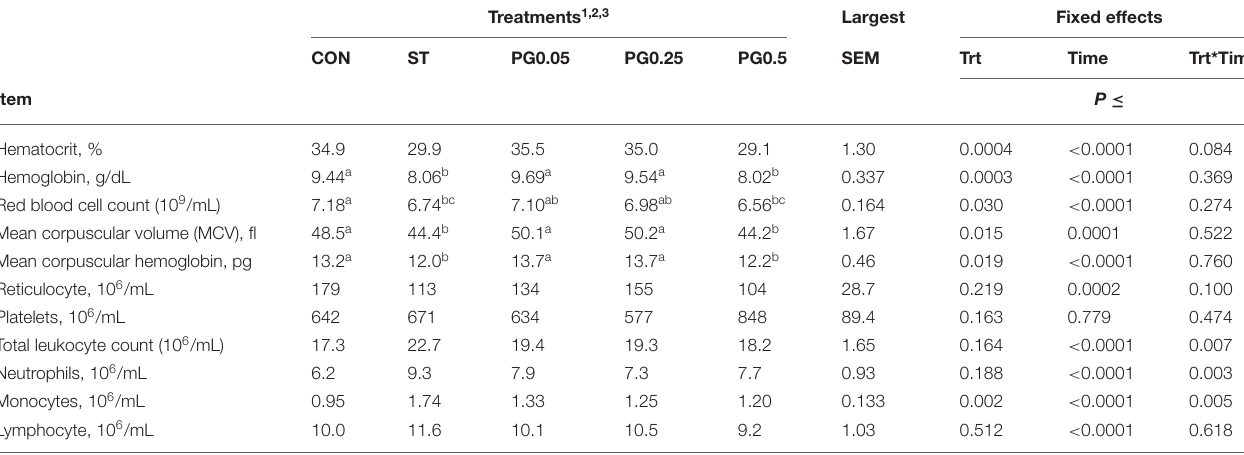
TABLE 3 | Hematological effects of a ceramic particle fed to pigs after a S. enterica serotype typhimurium infection. Treatments 1,2,3 Largest Fixed effects CON ST PG0.05 PG0.25 PG0.5 SEM Trt Time